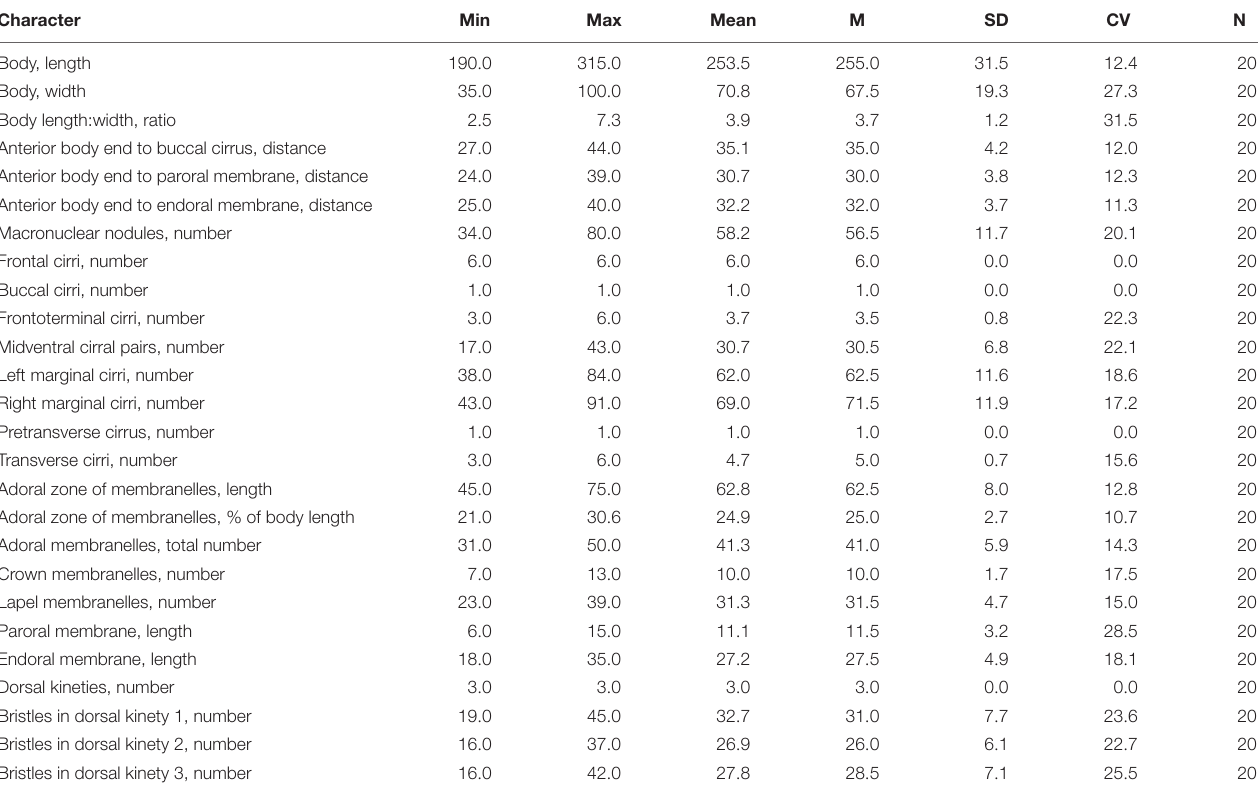
TABLE 1 | Morphometric characterization of Nothoholosticha luporinii n. sp.